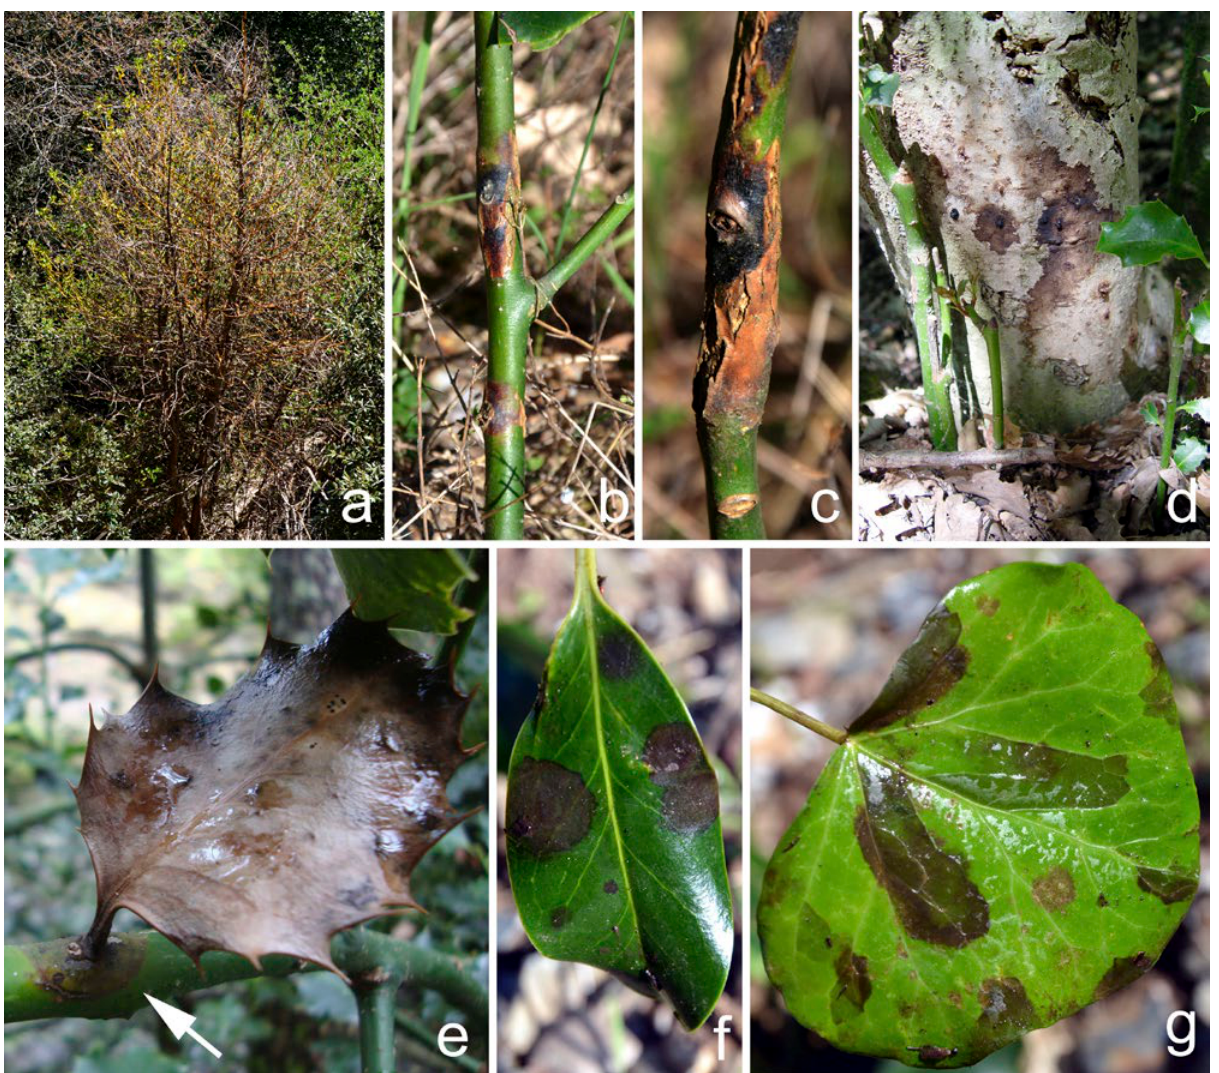
Figure 1. Disease symptoms on Ilex aquifolium : mature tree showing complete defoliation (a), twig cankers (b), detail of a twig canker with brownish-orange suberized tissues during the dry season (c), bleeding lesion on the stem (d), fresh le- sion around an axillary node (arrow) (e), black rounded spots on the leaf (f). Necrotic lesions on a heavily infected leaf of Hedera helix